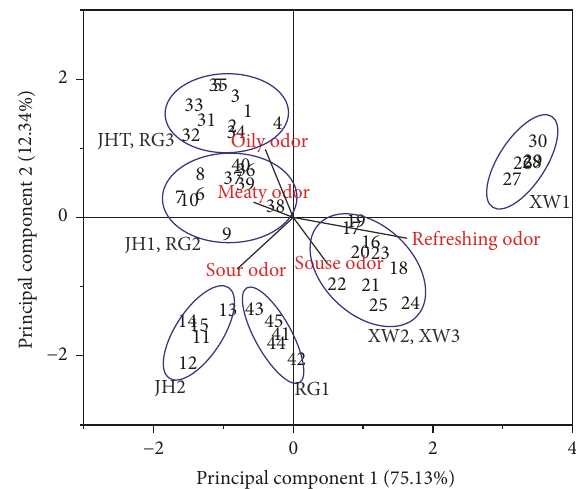
Figure 4: Principal component analysis biplot for ham samples and sensory descriptors. JHT: 1-5, JH1: 6-10, JH2: 11-15, XW3: 16- 20, XW2: 21-25, XW1: 26-30, RG3: 31-35, RG2: 36-40, and RG1: 41- 45. The abbreviations in the figure are referred to in Grades of Ham Samples and Their Abbreviations.